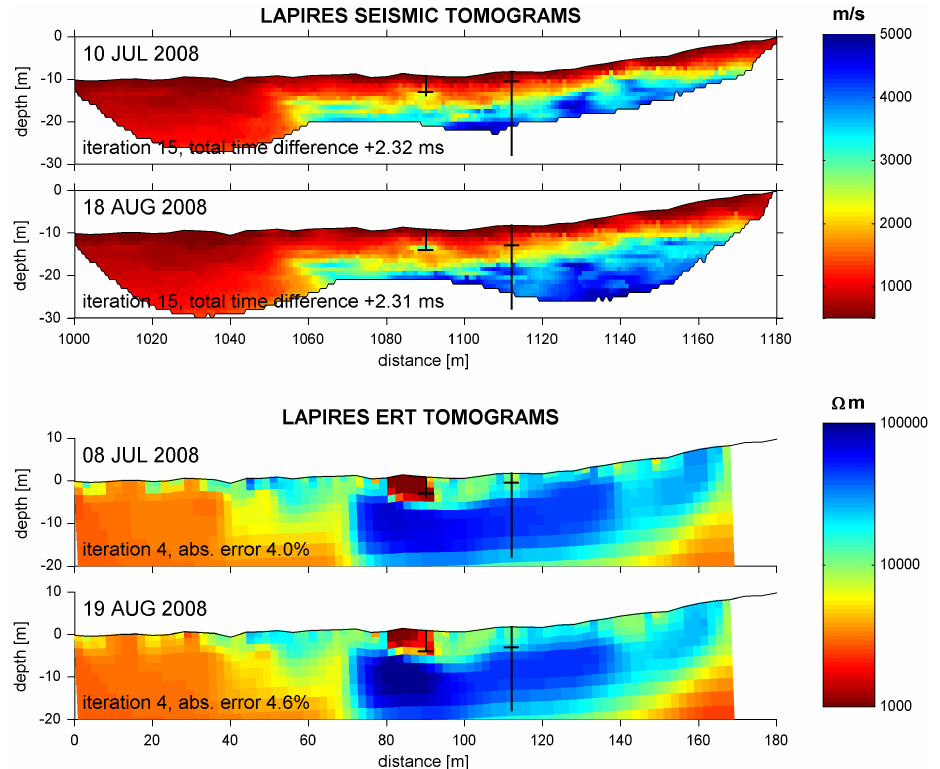
Fig. 8. Comparison of seismic tomograms (upper panels) from 10 July and 18 August 2008 at Lapires with ERT tomograms (lower panels) from comparable dates. Locations of the pylon and the borehole are indicated, as well as the respective thaw depth at both